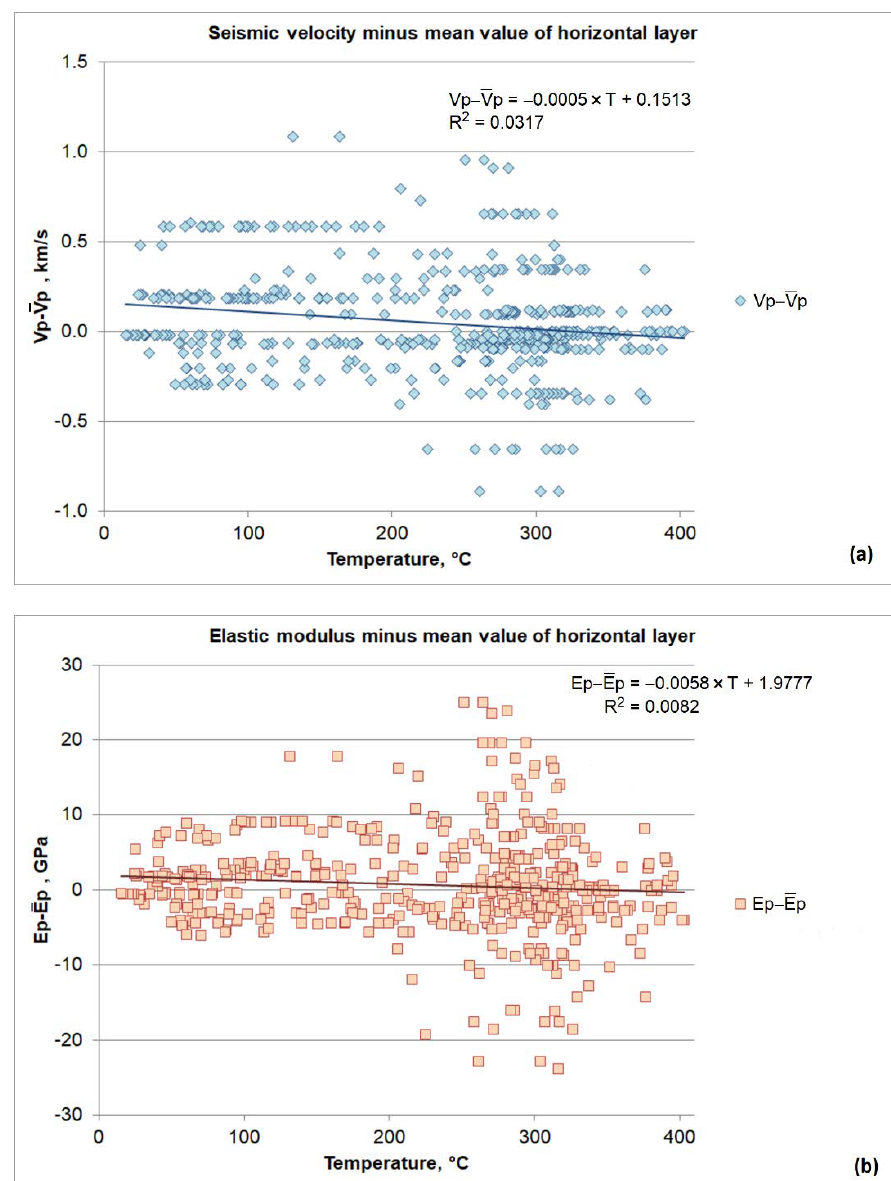
Figure 6. Seismic p -wave velocity V P ( a ) and elastic modulus E P ( b ) minus their average values at the same elevation above sea level, as derived from the active seismic survey, versus temperature in Los Humeros.